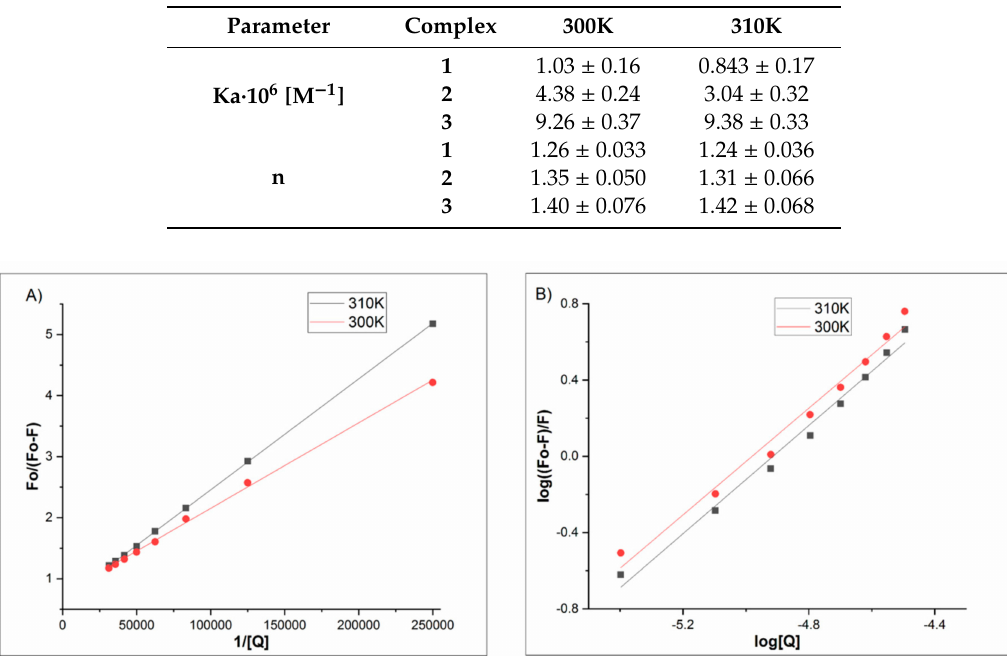
Figure 6. Modified Stern–Volmer ( A ) and log((F 0 – F) / F) vs. log(Q) ( B ) plots of the apo-Tf- 3 system at 300 K and 310 K (PBS, pH = 7.40, λ ex =